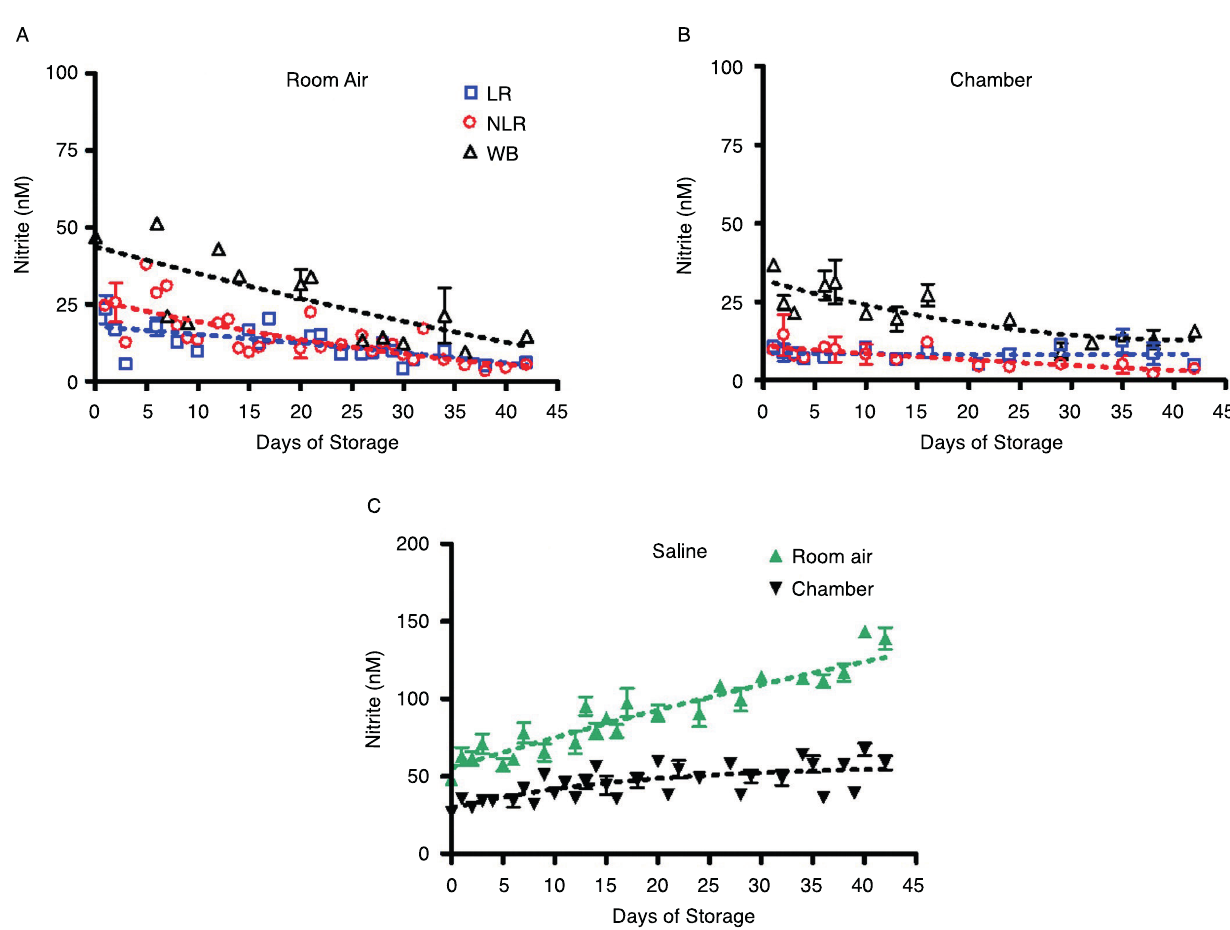
Figure 3. Nitrite concentration in supernatants and saline stored in room air or an argon chamber. Figure 3A shows the nitrite concentration in supernatants stored in room air, number of donors, n=3, while Figure 3B shows the same for supernatants stored in an argon chamber, number of donors, n=3. Nitrite concentrations in saline controls stored under both conditions are shown in Figure 3C, number of donors, n=6 (room air n=3, argon chamber n=3).